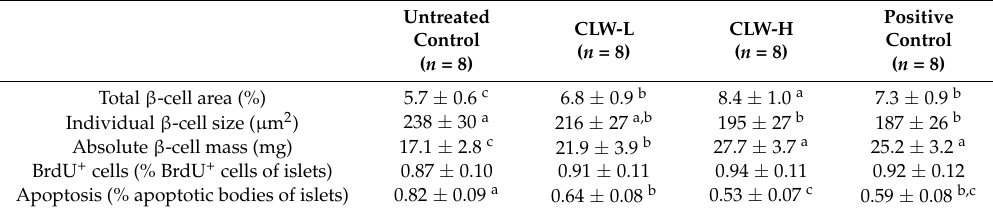
Table 3. The modulation of islet